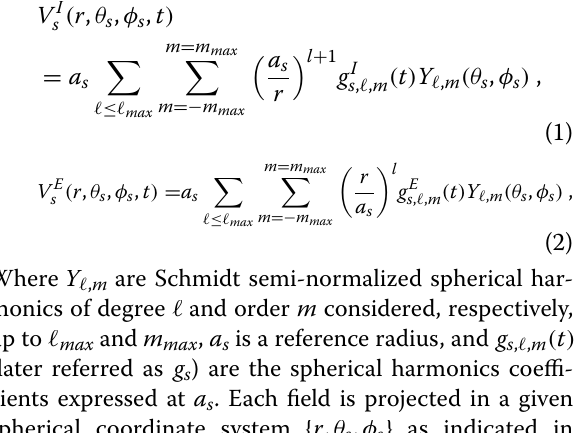
GEO geographic, SM solar magnetic, MAG magnetic, GSM geocentric solar magnetospheric ℓ max and m max are, respectively, the maximum degree and order of the SH expansion a POGO, MagSat, Oersted data.